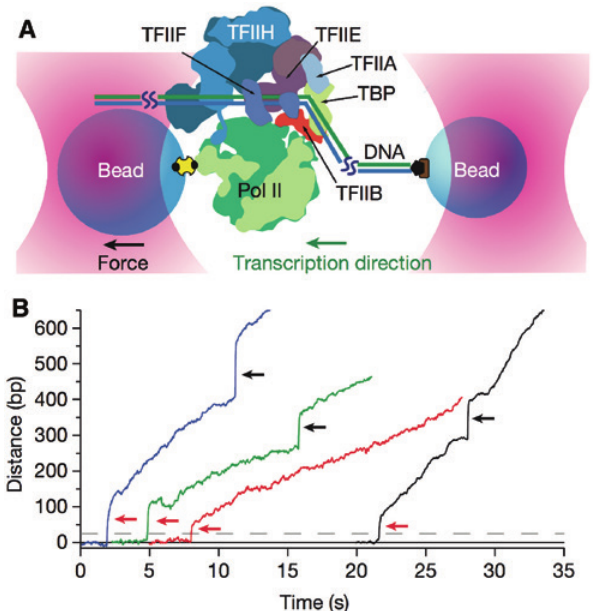
Figure 2: Transcription initiation by Pol II in assisting force mode. (A) Schematic diagram of the transcription initiation assisting force mode set-up, where a tether is formed between the two beads (blue), with Pol II attached to one bead, and the upstream DNA attached to the second bead. As transcription proceeds, the distance between the beads increases. All proteins used for initia- tion are depicted here, except Sub1. The scheme is not to scale. (B) Representative traces of Pol II elongation, where red arrows mark the promotor escape and the black arrows mark the increase of force that was used to confirm elongation. Adapted from Ref. (10) with permission from Nature Publishing